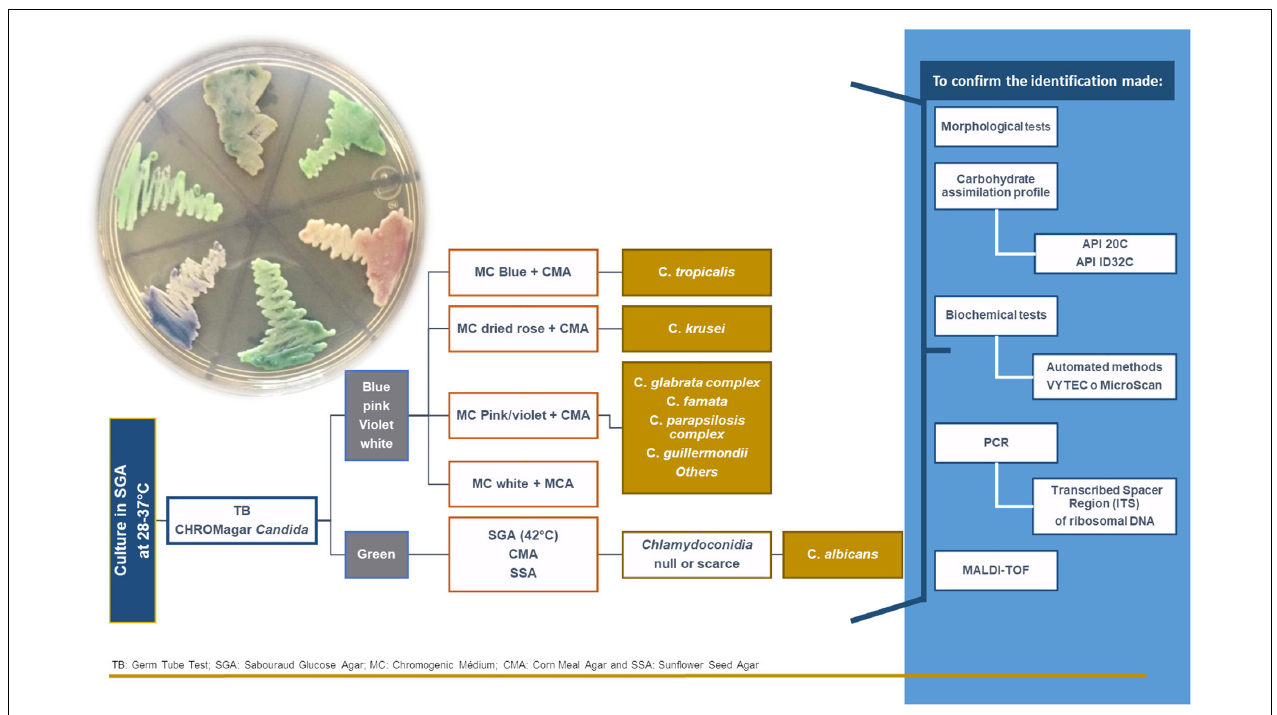
FIGURE 1 | The algorithm used for the identification of Candida